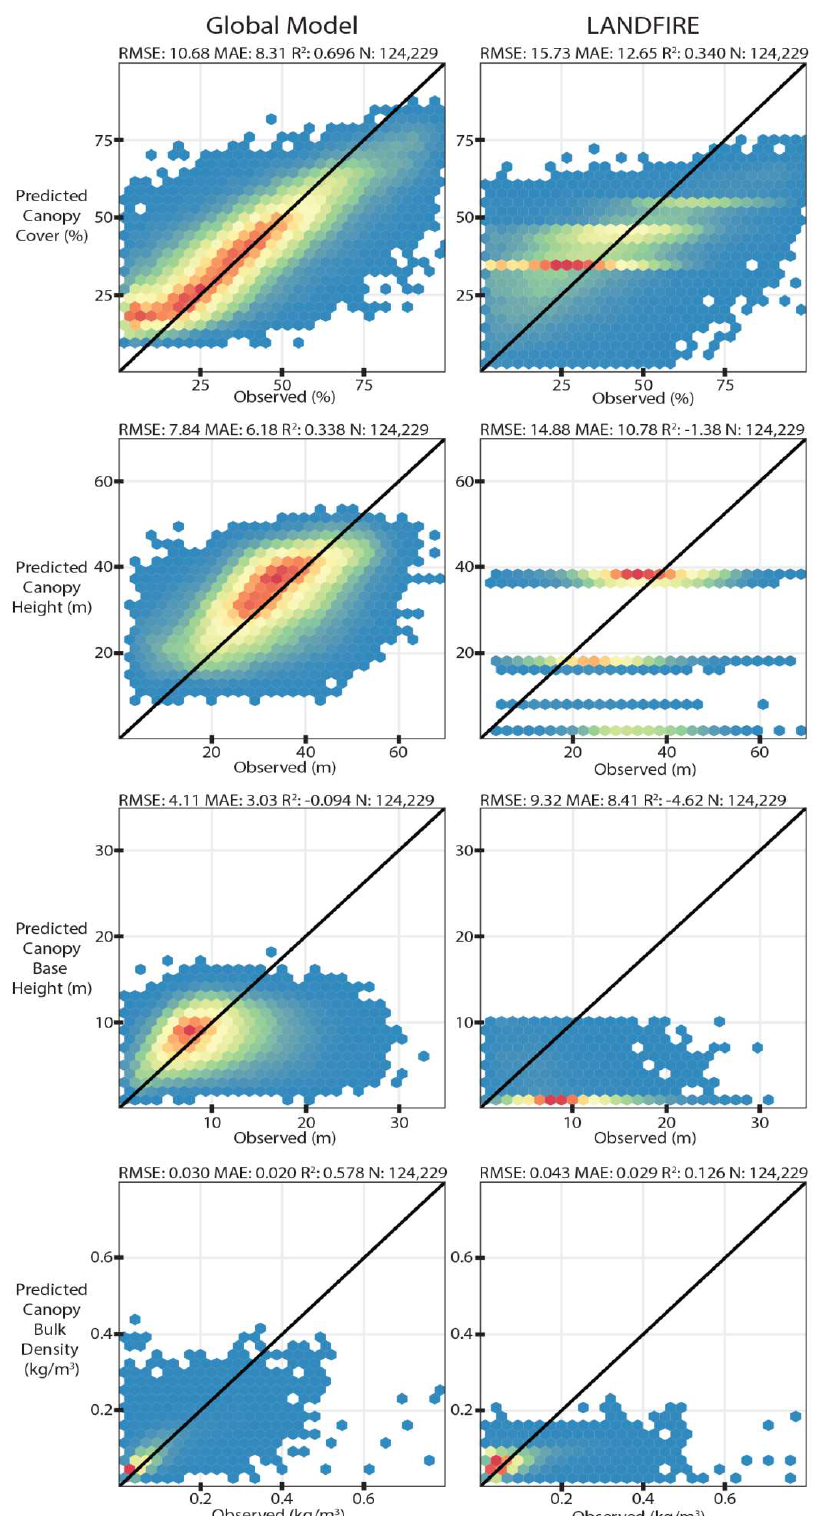
Figure 7. Predicted versus observed plots for the Illilouette test landscape using the global GBM model ( left column ) and existing LANDFIRE layers ( right column ). Point density indicated with blue ( low ) to red ( high ) gradient.